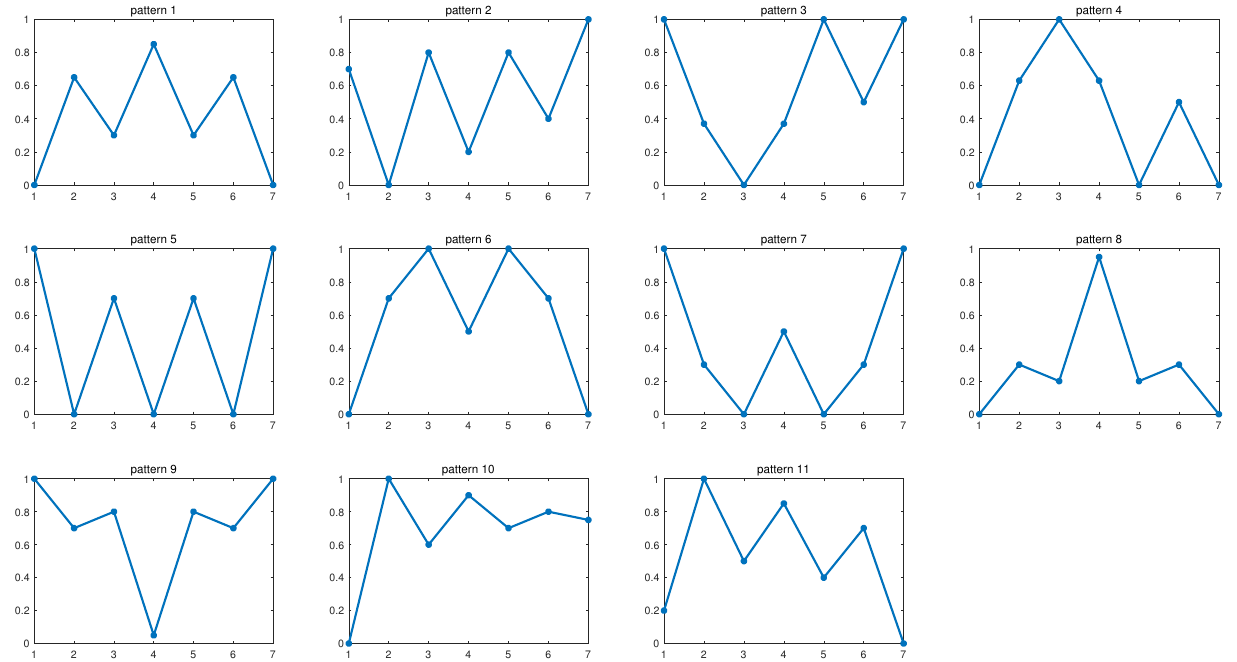
Figure 5. Eleven template patterns, each pattern is represented by 7 PIPs. (H&S, Triangles ascending, Cup with handle, Reverse cup with handle, Triple bottoms, Double tops, Double bottoms, Spike top, Spike bottom, Flag,